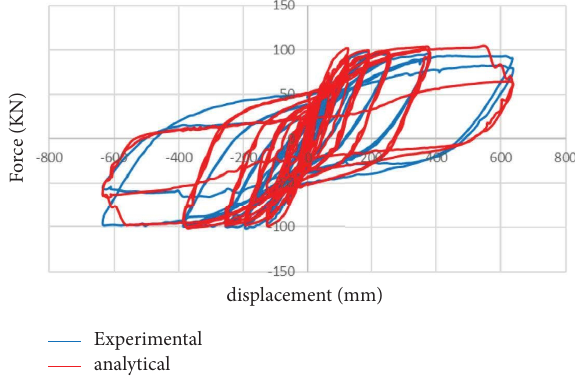
Figure 5: Concrete column behavior